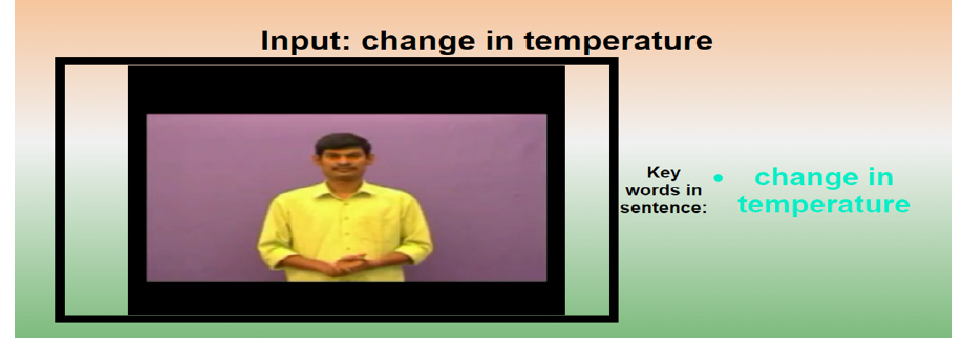
Figure 9. Case 2. Available video for ‘change in temperature’.